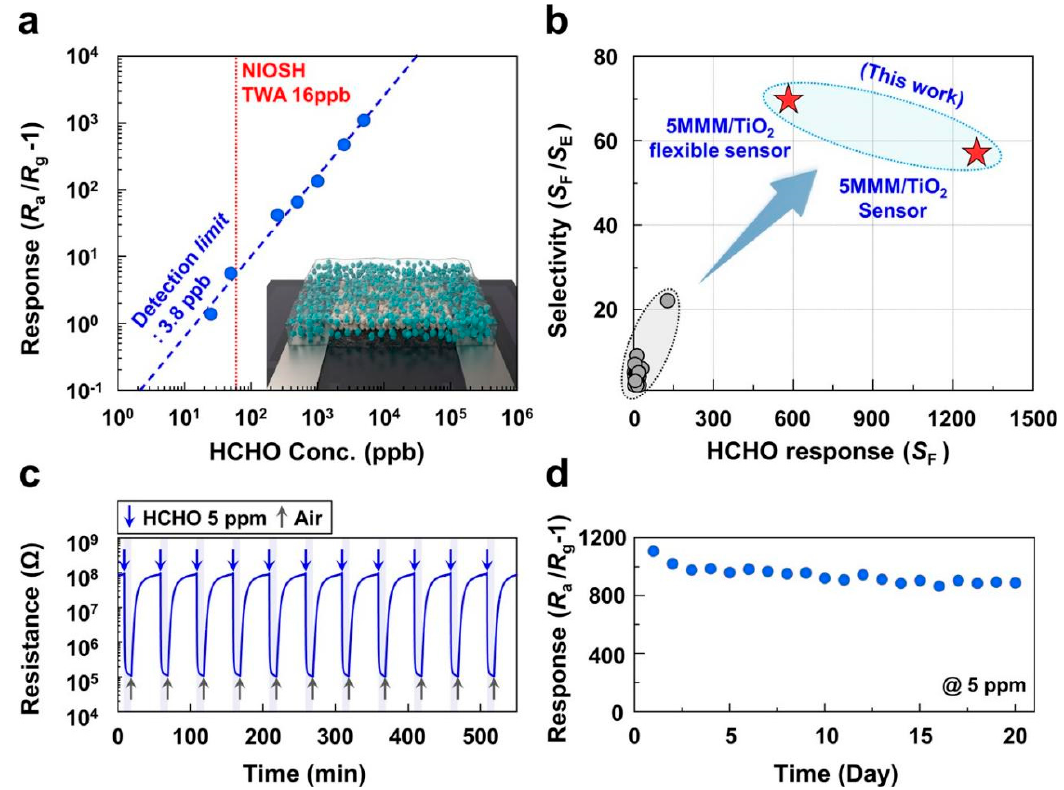
Figure 4. Low detection limit, formaldehyde selectivity/response, dynamic response, and stability.